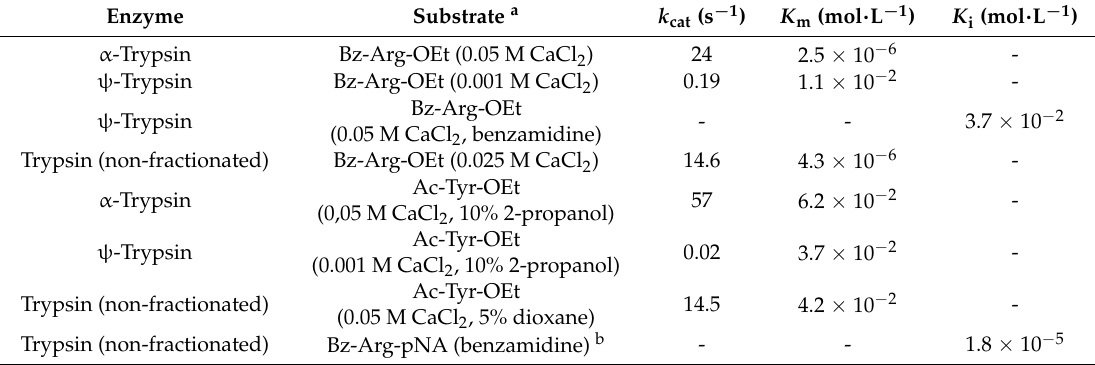
Table 1. Kinetic data for bovine α -trypsin and ψ -trypsin with artificial substrates. This table is adapted from Smith and Shaw [16] and completed by results with non-fractionated trypsin [43]. All experiments were performed at pH 8.0 and 25 ◦